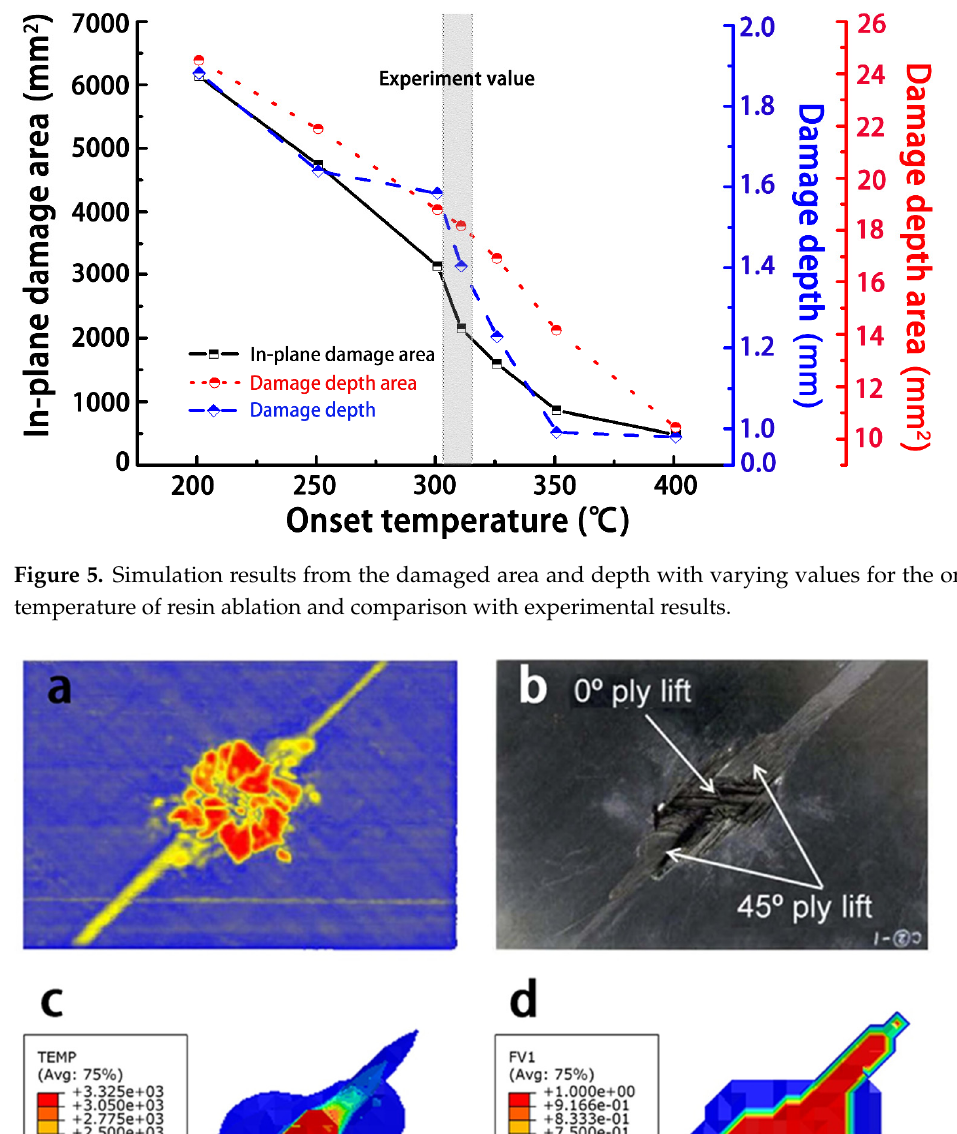
Figure 7. Comparisons between the experimental and simulated results for the depth damage: ( a ) depth damaged area after lightning strike [21]; ( b ) simulated depth damage results from the iso- thermal pyrolysis diagram; and ( c ) non-isothermal pyrolysis method. 3. Results and Discussions 3.1. Influence of the Composite Structural Parameters on the Extent of Lightning Damage The injected current from the lightning strike was primarily dissipated along the con- ductive fiber in the CRFP. In addition, changes in the structural geometry of the composite and laminate material sequences also determined the length of the path to the ground. In this section, the structural geometry parameters that can be tuned to improve the internal current export from the CRFP to reduce the associated lightning damage are discussed. 3.1.1. Thickness